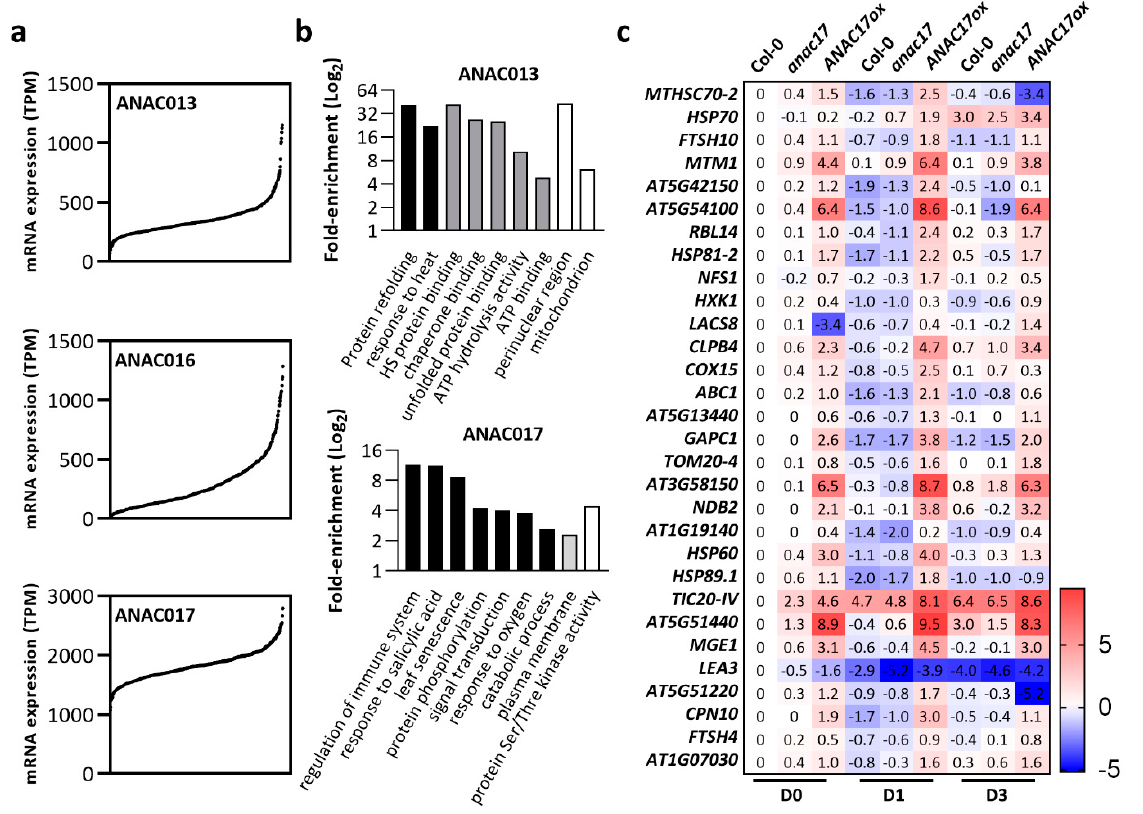
Figure 3. Transcripts co-expressed with ANAC013 are differentially expressed in ANAC017 overex- pressor lines under normal growth conditions and during senescence. ( a ) ANAC013 , 16 , and 17 mRNA expression in ascending order across a global collection of 727 Arabidopsis thaliana accessions [81]. The dataset was obtained from GEO within the NCBI database. Original transcriptome data were deposited to the GEO at the NCBI under accession number GSE80744. Specific data points are not comparable between graphs. ( b ) Co-expression analysis was conducted individually for ANAC013, 16, and 17 across the accessions within the abovementioned dataset (GSE80744) to obtain the Pearson correlation coefficient. Genes were considered as co-expressed using a Pearson correlation cutoff value ≥ 0.5. A Gene Ontology enrichment analysis was conducted using the co-expressed genes as queries against the complete Arabidopsis transcriptome as background. Gene ontologies were considered enriched using a twofold and FDR < 0.05 cutoff. Black bars: biological process, gray bars: molecular function, white bars: cellular compartment. ( c ) A total of 30 mitochondrial targeted genes, as annotated at TAIR Subcellular Prediction, were found as co-expressed with ANAC13. The expression of these 30 mitochondrial genes was searched in Col-0, anac17 , and ANAC17ox lines during dark-induced senescence [92]. Original datasets used to build this heatmap are available at ArrayExpress under the following accession number: MTAB-8478. Relative expression is expressed as log 2 fold-change compared to untreated Col-0 plants. For definitions of gene symbols and for a complete description of the gene names shown in the heatmap, please see Table S2. D0: Control plants, D1: senescence in individually darkened leaves for 1 day, D3: senescence in individually darkened leaves for 3 days.